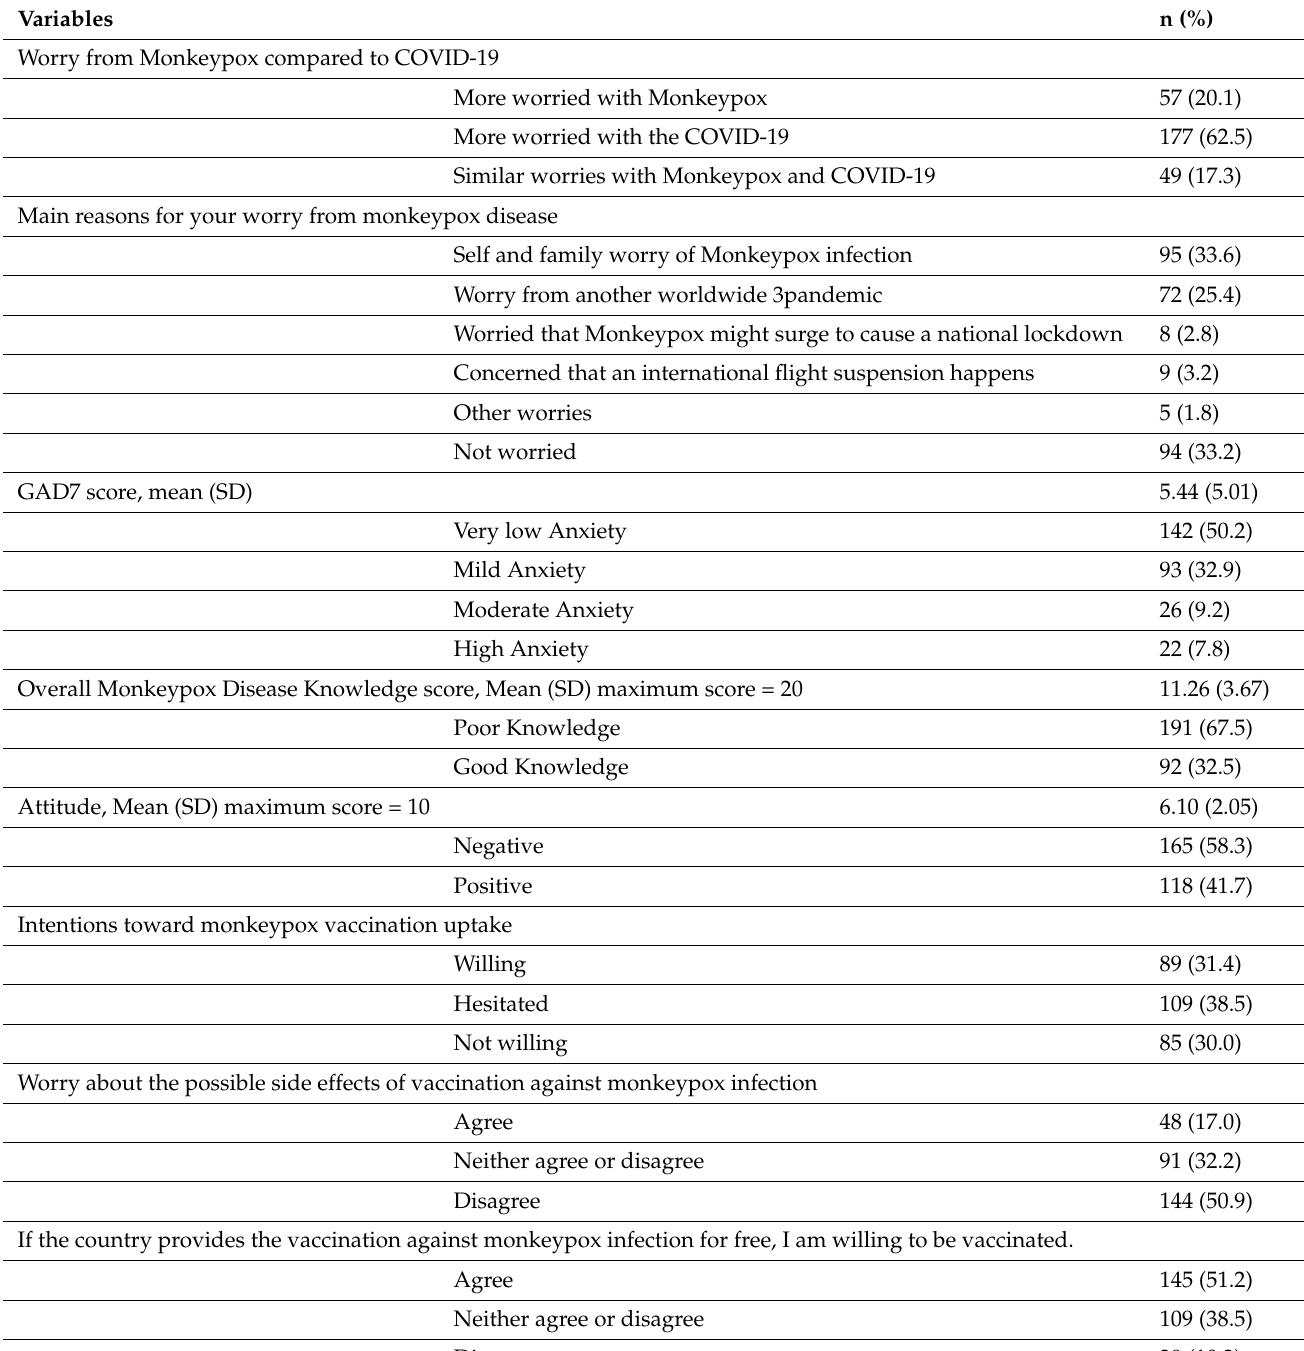
Table 3. Respondents’ attitudes, perceptions, and beliefs about monkeypox disease (N =